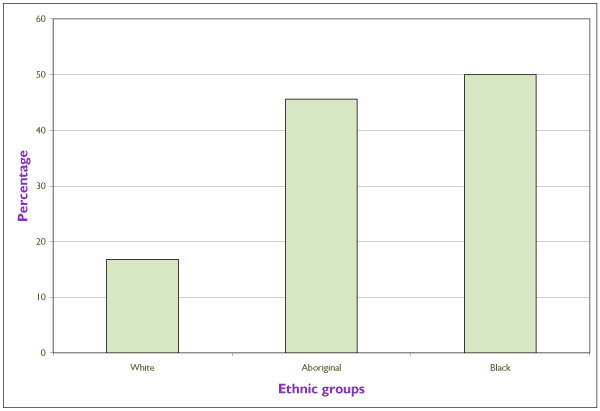
Proportion of Women among Positive HIV Test Reports, by Ethnic Group, 1998–2001 Source: Data from HIV and AIDS in Canada, Surveillance Report to December 31, 2001.